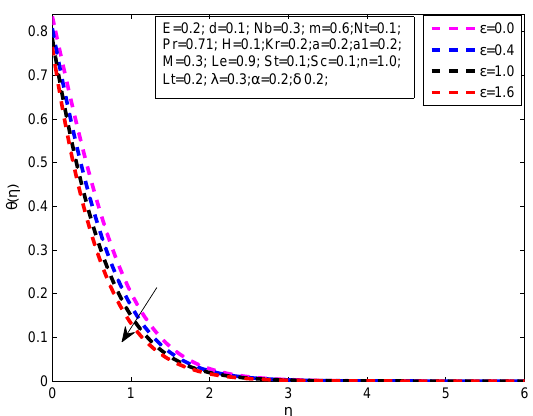
Figure 21. Variation of θ for distinct values of ε .